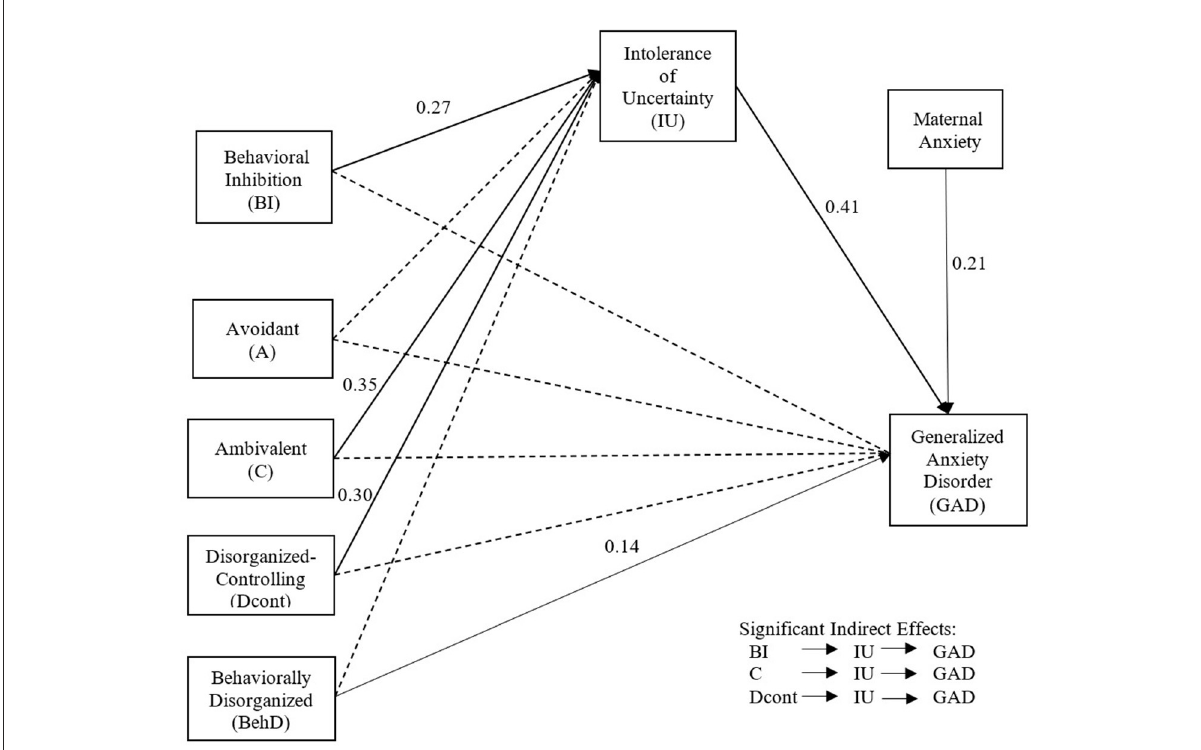
FIGURE2 Final model of direct and indirect effects of behavioral inhibition and attachment on GAD symptoms through IU, controlling for maternal anxiety.